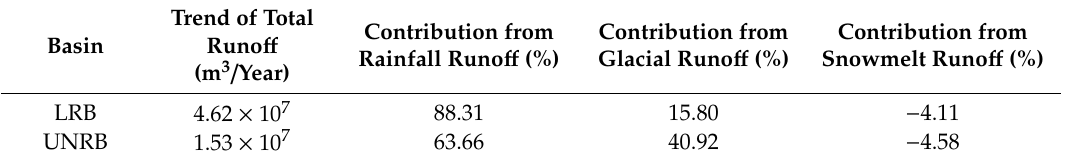
Table 6. Ratio contribution for attributing the trend of total runo ff to three runo ff components during 1963–2012 in the two